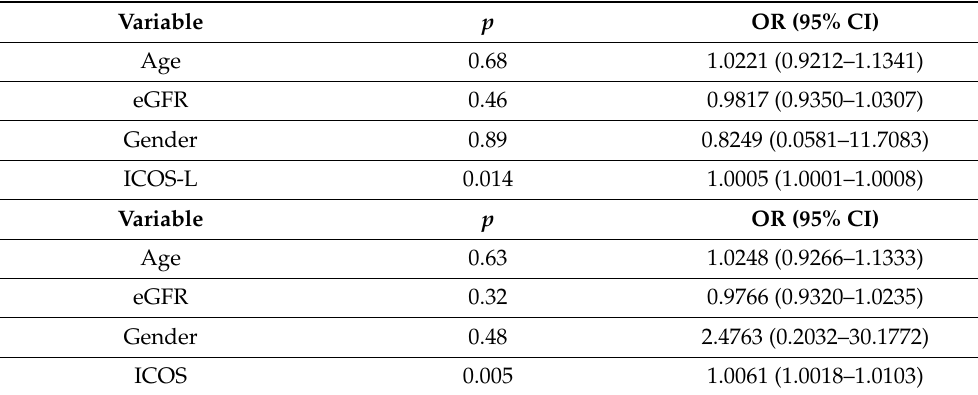
Table 2. Multivariate analysis of variables associated with PH. The table shows two multivariate analyses investigating the association of ICOS and ICOS-L with the diagnosis of PH. Abbreviations: eGFR: estimated glomerular filtration rate; ICOS: inducible co-stimulator; ICOS-L: inducible co- stimulator ligand.